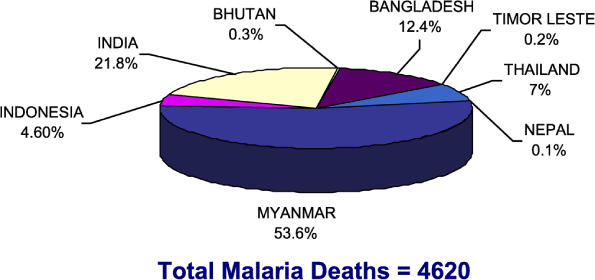
Distribution of Reported Malaria Deaths in Southeast Asia, 2003Burma accounts for about 7% of malaria cases reported in Southeast Asia, including India, yet over half the malaria deaths in the region occur in this country.Source: WHO, SEAR [75]